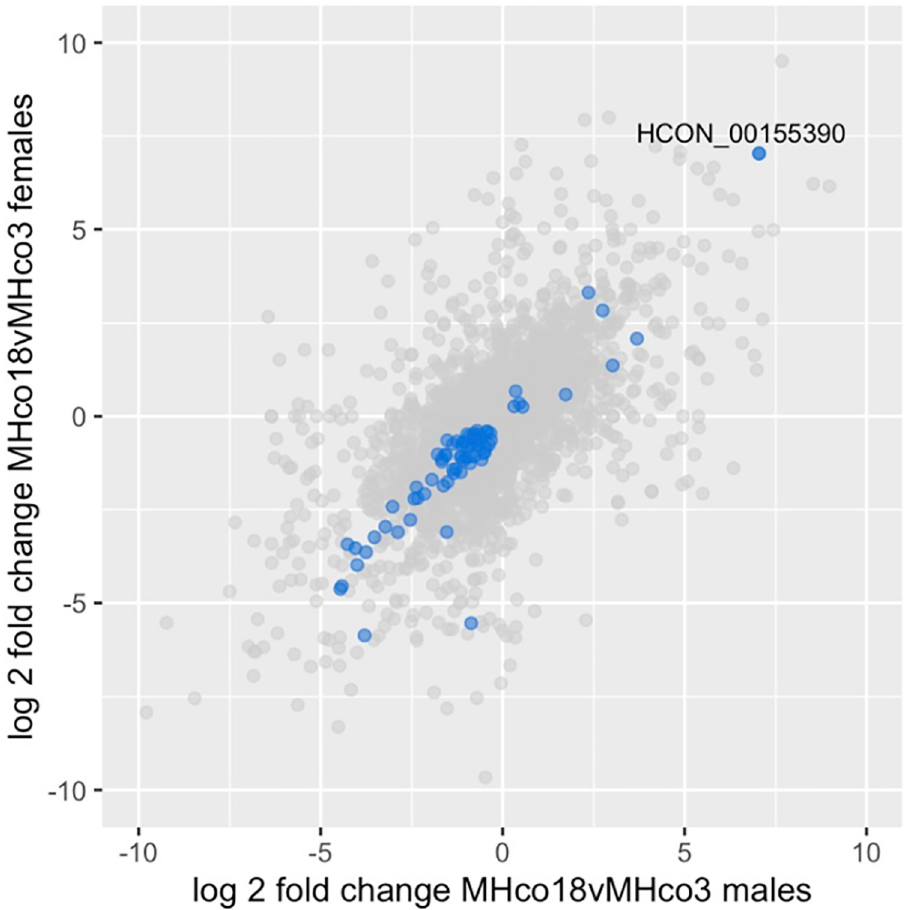
Fig 2. Scatter plot showing differentially expressed genes in comparisons of resistant and susceptible populations (adj P < 0.01), with log2 fold change of males shown on the x-axis and females on the y-axis. Grey points represent genes that are differentially expressed only in parental (MHco18 vs MHco3) comparisons, i.e. likely to represent between- strain differences not associated with ivermectin resistance. If blue they are also differentially expressed in the F2IVM vs MHco3 and F2IVM vs F2CTL comparisons, i.e. likely to be specifically associated with ivermectin resistance. The most highly upregulated gene in resistant isolates is the H . contortus homologue of C . elegans cky-1 (HCON_00155390). Equivalent scatterplots for all pairwise comparisons are shown in S5 Fig.